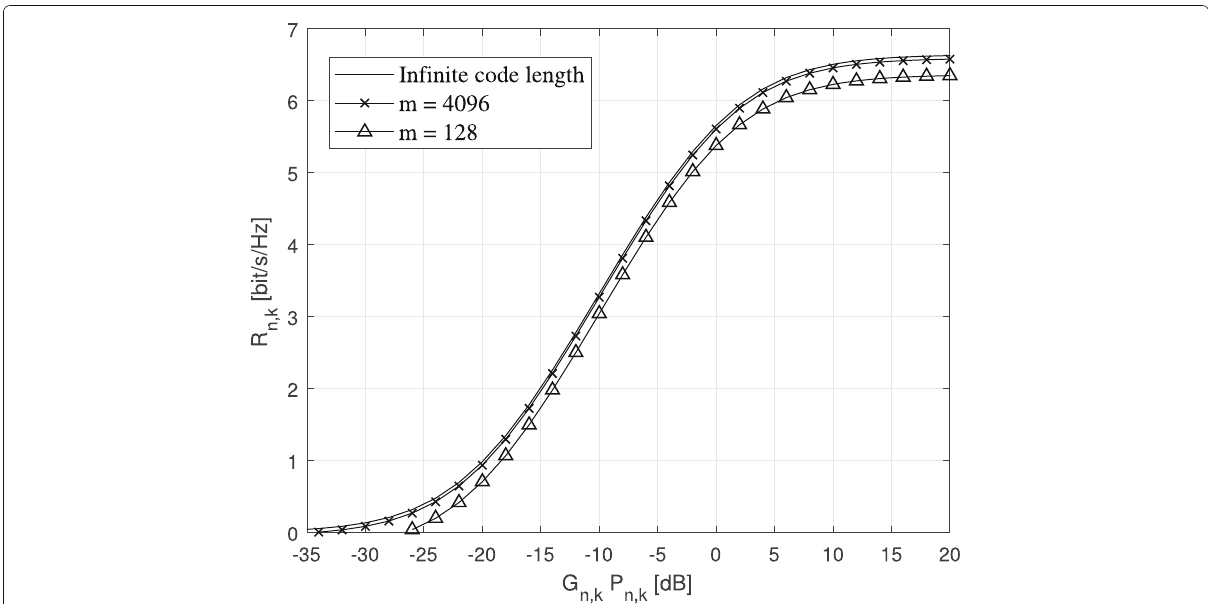
Fig. 2 R n , k ( P n , k ) as a function of G n , k P n , k for H n , k / G n , k equals to 20 dB, for infinite-length codes and codes of length 4096 and 128, and θ =